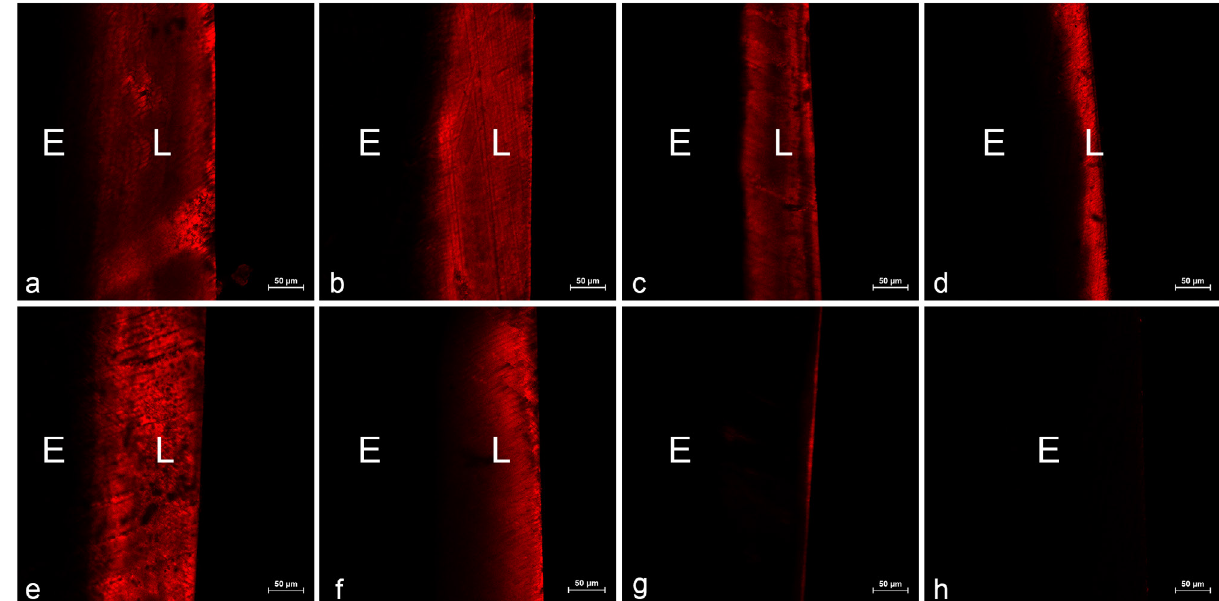
Figure 5- Cross-sectional confocal laser scanning microscopy (CLSM) images of the specimens after each treatment (magnified at 200×; L: lesion; E: intact enamel). (a) negative control; (b) 0.08 mg/mL rGO/Ag; (c) 0.12 mg/mL rGO/Ag; (d) 0.16 mg/mL rGO/Ag; (e) 0.16